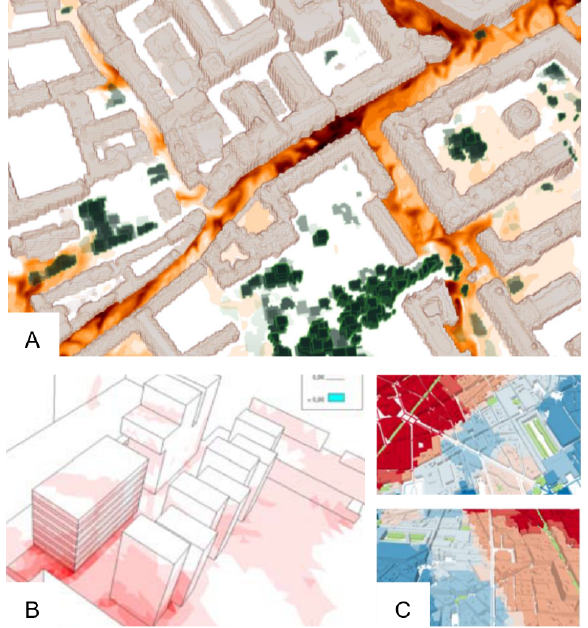
Figure 1. Using ground and building color to represent 2D and 3D scalar data; (A) Air quality data represented by the color of the ground (Kurppa et al., 2020); (B) Representation of the gap between simulated building surface temperature and meteorologic air temperature data (Bouyer, 2009); (C) Using colored buildings to represent simulated air temperature data close to the ground surface (Pinson, Masson, 2016).